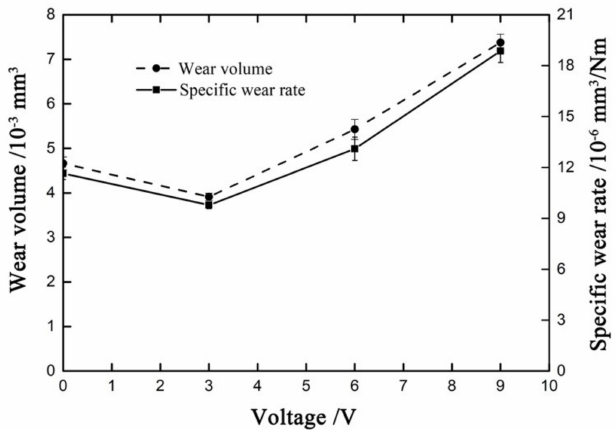
Figure 22. Wear volume and specific wear rate versus voltage with F n = 50 N, D = ± 20 µ m and ƒ = 15